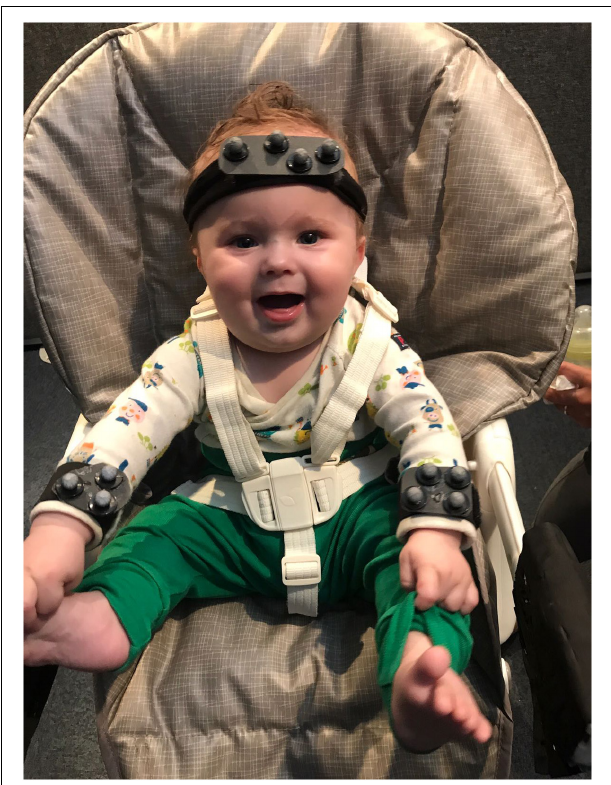
FIGURE 2 | Motion tracking systems allow for precise tracking of infant’s limb or head movement. The position of light reflecting spheres attached to the infant body is triangulated with the help of a system of surrounding cameras. This system is light and does not interfere with infant’s